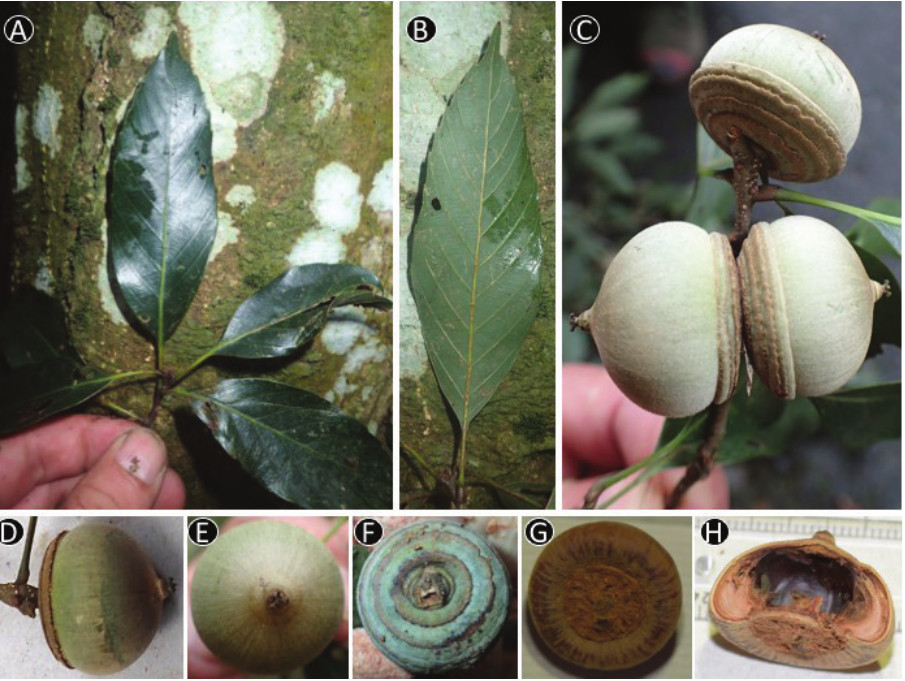
Figure 4. Image of Quercus disciformis Chun & Tsiang. from Binh et al. V6058 (FU) A Leafy twig B Abaxial side of mature leaf C–D Infructescence and mature fruit E Nut F Cupule G Bottom of nut H Vertical section of